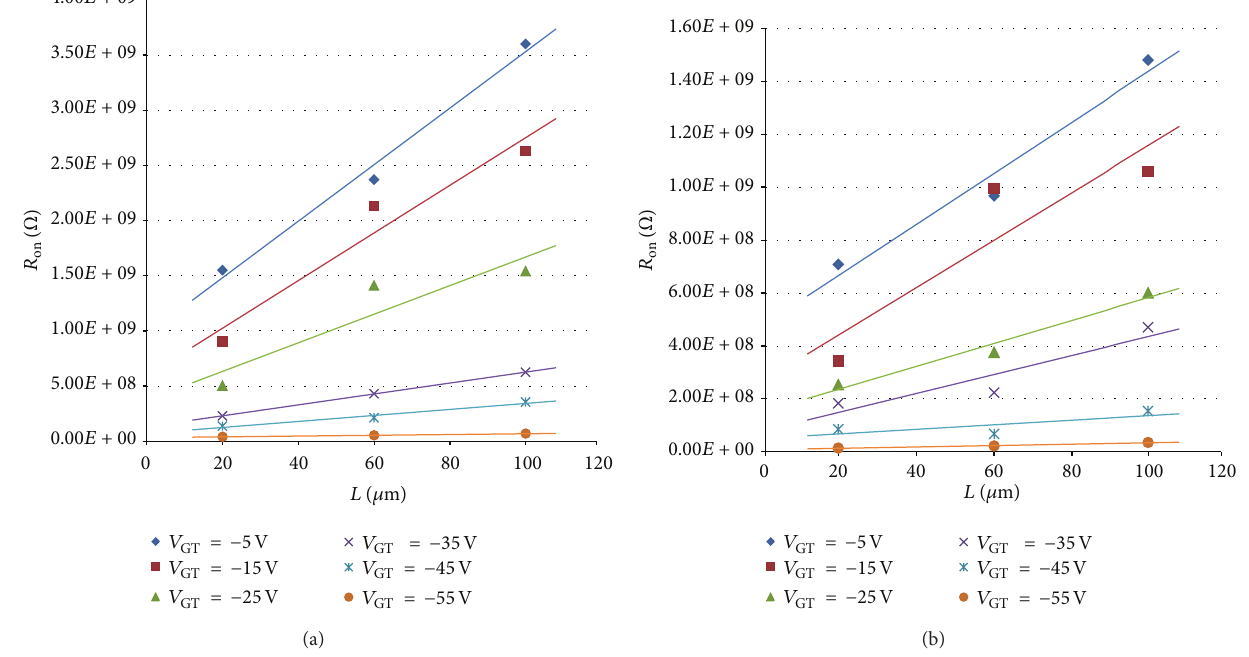
for (a) pristine P3HT and (b) CNP/P3HT = GT